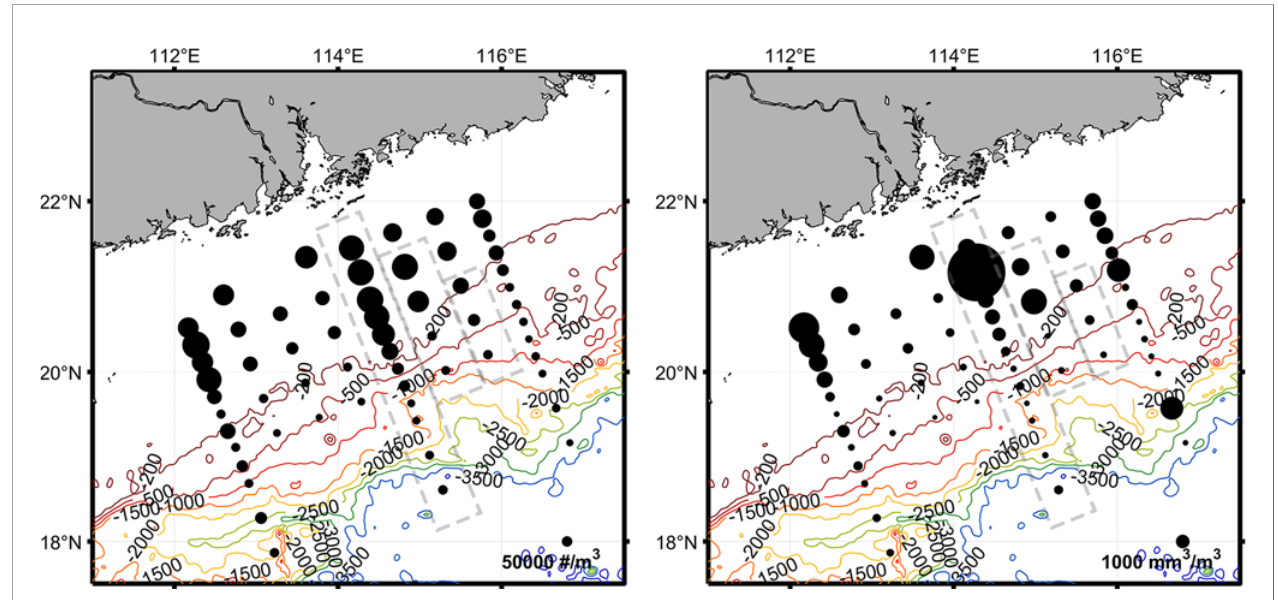
FIGURE 5 | The water column average of plankton abundance distribution (#/m 3 , left panel) and biovolume concentration (mm 3 /m 3 , right panel) in northern SCS. The gray dashed boxes are the stations sampled after the